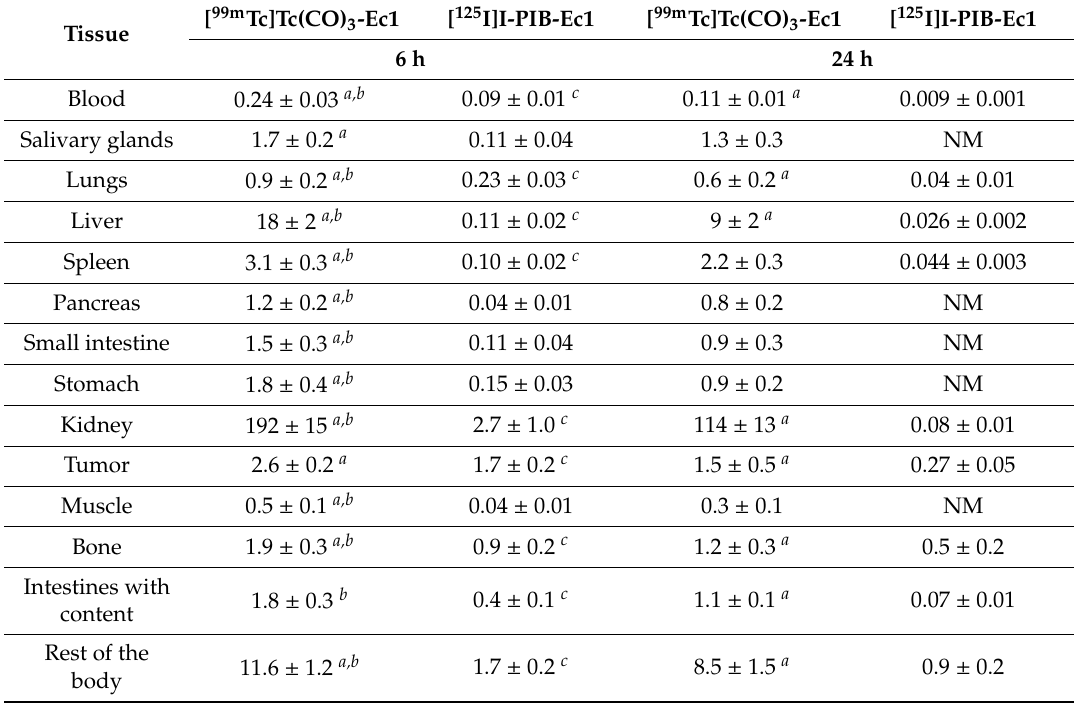
Table 4. Biodistribution of [ 99m Tc]Tc(CO) 3 -Ec1 and [ 125 I]I-PIB-Ec1 in Balb / c nu / nu mice bearing MDA-MB-468 xenografts 6 and 24 h pi.